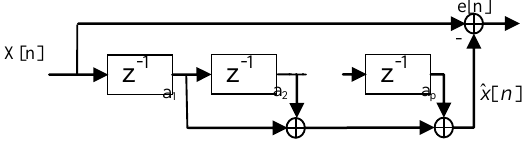
Figure 1. Signal estimation using LPC